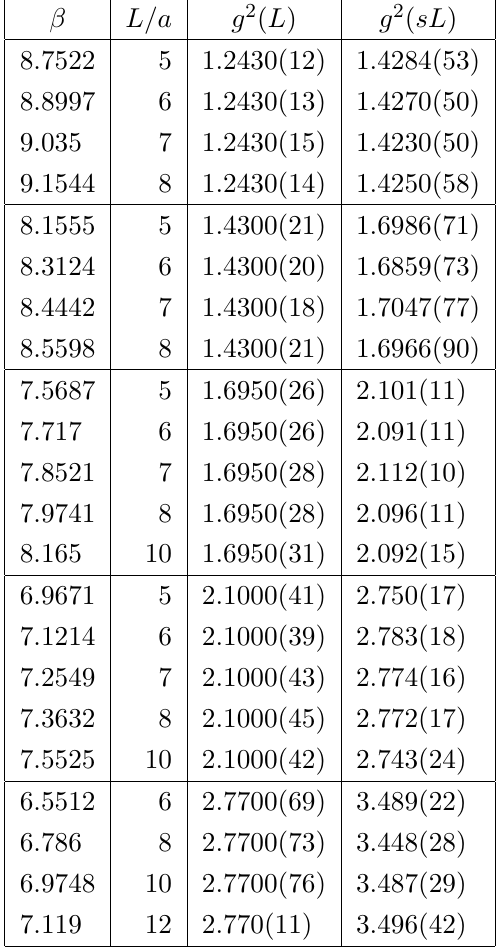
Table 12 . Evolution of the renormalized coupling at di(cid:11)erent length scales, reproduced from ref. [32, table 2]. s = 2 for the (cid:12)rst four sets of data, while s = 3 = 2 for the last data set, corresponding to g 2 ( L ) ’ 2 :